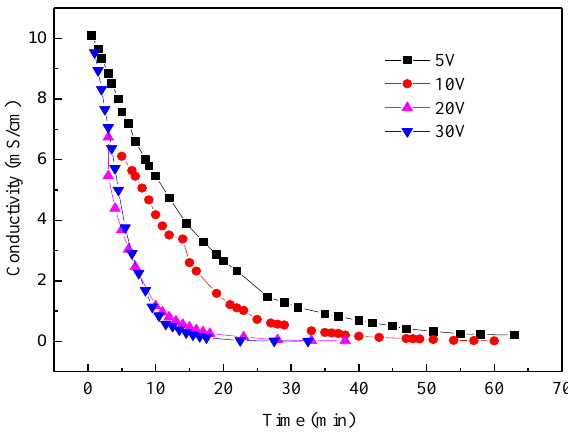
Figure 2. Effect of voltage drop on conductivity changes in the diluate chamber.